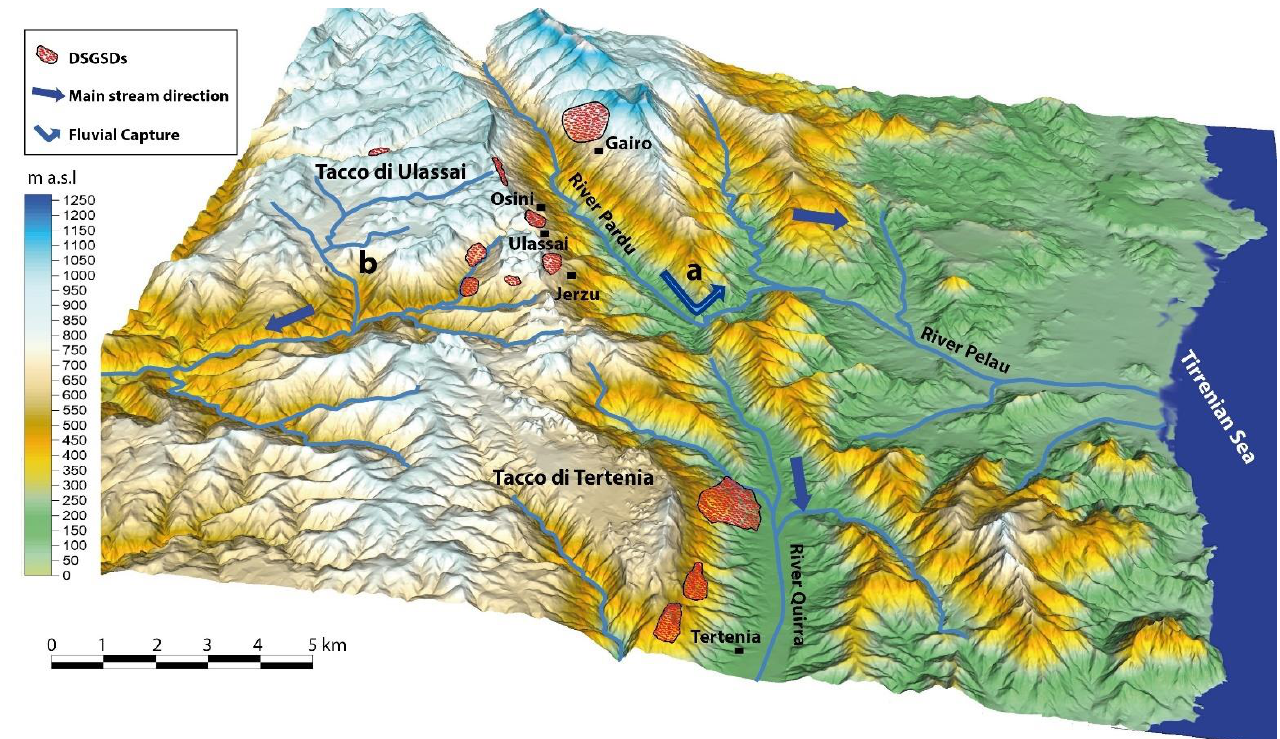
Figure 4. Three-dimensional (3D) model of the Pardu River and Quirra River. Blue lines represent major hydrographic features, and red areas represent the major DGSDs. (a) Fluvial capture elbow; (b) Lequarci waterfall.